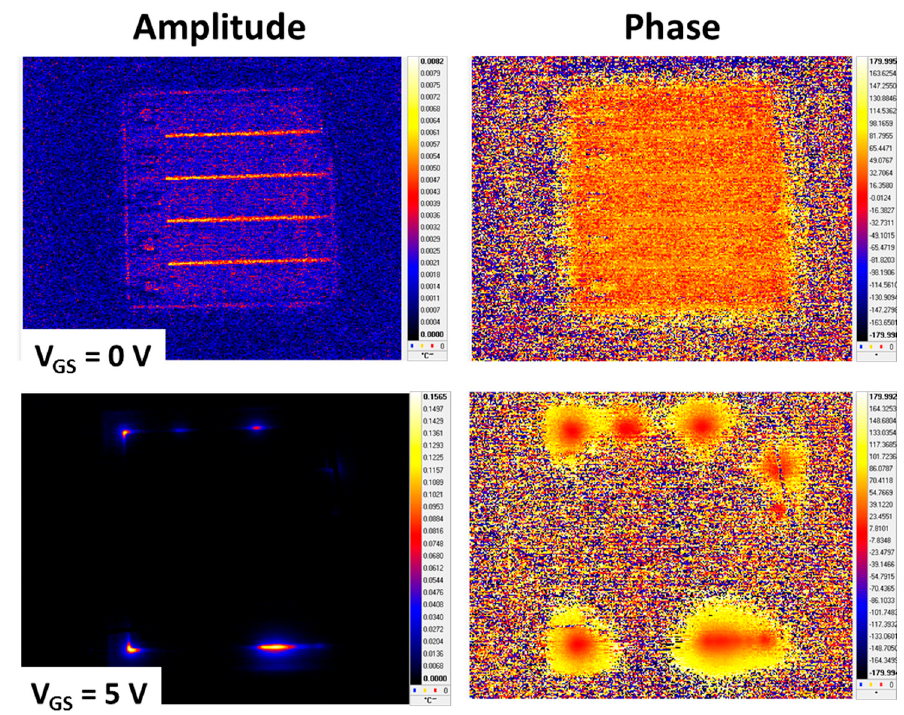
Figure 11. Lock-in thermography amplitude and phase images, obtained with a Drain voltage modulation of ∆ V = 5 V around the breakdown value ( V DS = − 300 V), for a V-JFET sample biased in conduction ( V GS = 0 V; top side ), and blocking ( V GS = 5 V; bottom side ) modes. Hot spots responsible for the breakdown are not uniformly located at the peripheral Gate runner.